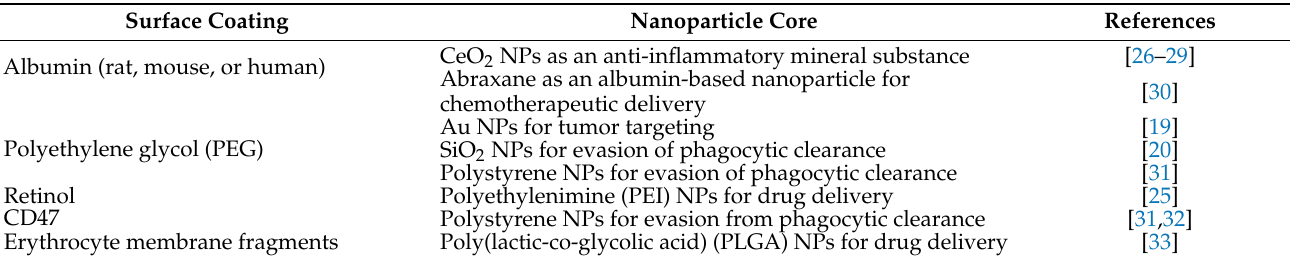
Table 1. Coatings employed to avoid immune